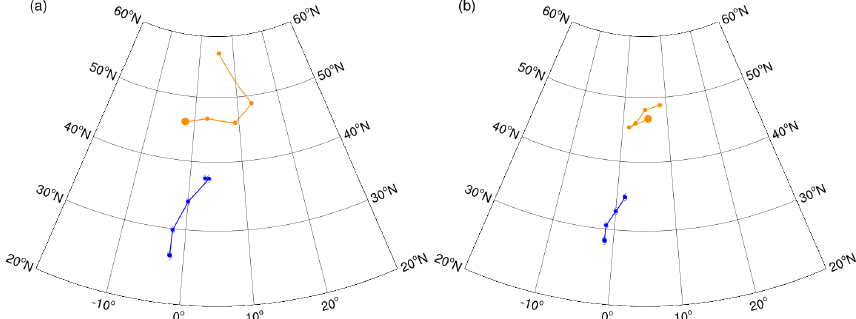
Figure 8. Track of the composite tropical cyclone (blue) and the downstream 500hPa extratropical ridge (orange) from Day − 2 to Day + 2 for (a) rapid curvature acceleration and (b) near-zero curvature acceleration. The composites are based on all TC track locations within 30–40 ◦ N. Day 0 is the reference day for the composites in Fig. 7.